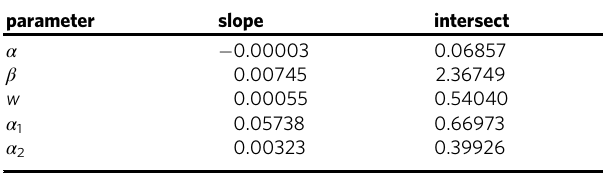
Table 1 Parameters of the multiple displacement ampli fi cation (MDA) ampli fi cation bias model as presented in Supplementary Fig. S5, panels C and D of ref. 22